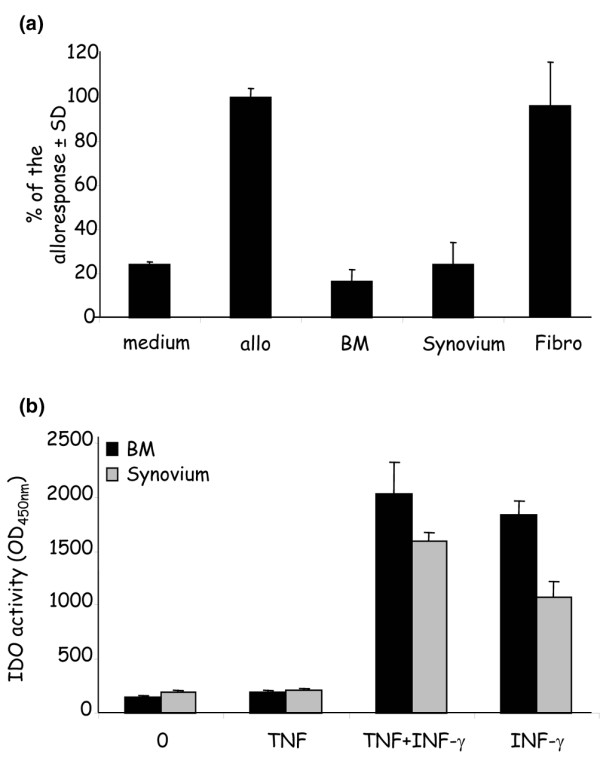
Immunosuppressive properties of bone marrow-derived and synovium-derived adherent cells. (a) Proliferative activity of T cells in a mixed lymphocyte reaction. Responding BALB/c splenocytes (105 cells) were incubated for 4 days with mitomycin-treated DBA/1 splenocytes (105) in the presence or absence of 105 adherent cells from bone marrow (BM) (n = 10; six healthy, two rheumatoid arthritis, two osteoarthritis) or synovium (n = 10; five rheumatoid arthritis, two osteoarthritis, three normal) or normal fibroblasts (fibro; n = 3). The proliferative response corresponding to the average counts per minute of triplicates of alloreactive T cells (allo) was assigned the value of 100% ± standard deviation (SD). (b) The indoleamine 2,3-dioxygenase (IDO) activity was detected as the tryptophan to kinurenin conversion measured at an optical density (OD) of 450 nm. Cells were cultured in the absence or presence of IFN-γ and/or tumor necrosis factor alpha (TNF-α) for 48 hours and the detection of kinurenin was measured by photometry. The IDO activity is expressed as the mean activity from four different samples of cells from each tissue ± SD.